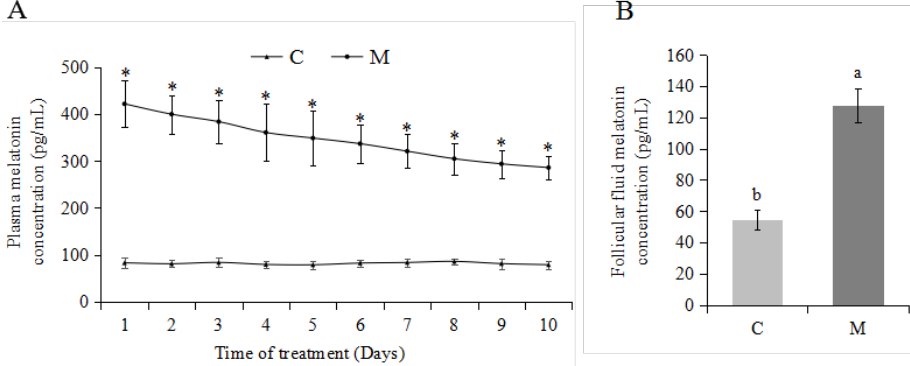
Figure 1. Melatonin concentrations in plasma and follicular fluid. ( n = 9). * p < 0.05 in Figure 1A; a,b in Figure 1B, for columns, means without a common superscript differed ( p < 0.05). ( A ) Melatonin concentrations of plasma, ( B ) melatonin concentrations of follicular fluid.